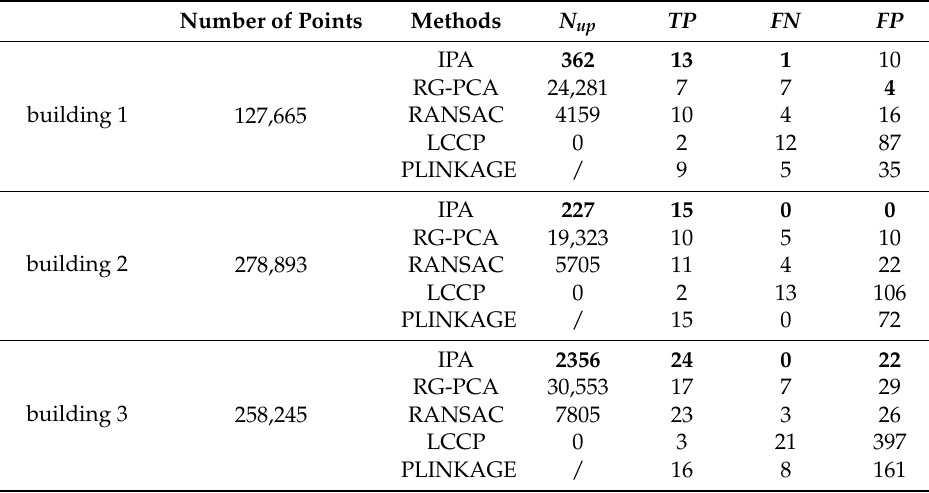
Table 2. Statistical analysis of surface extraction